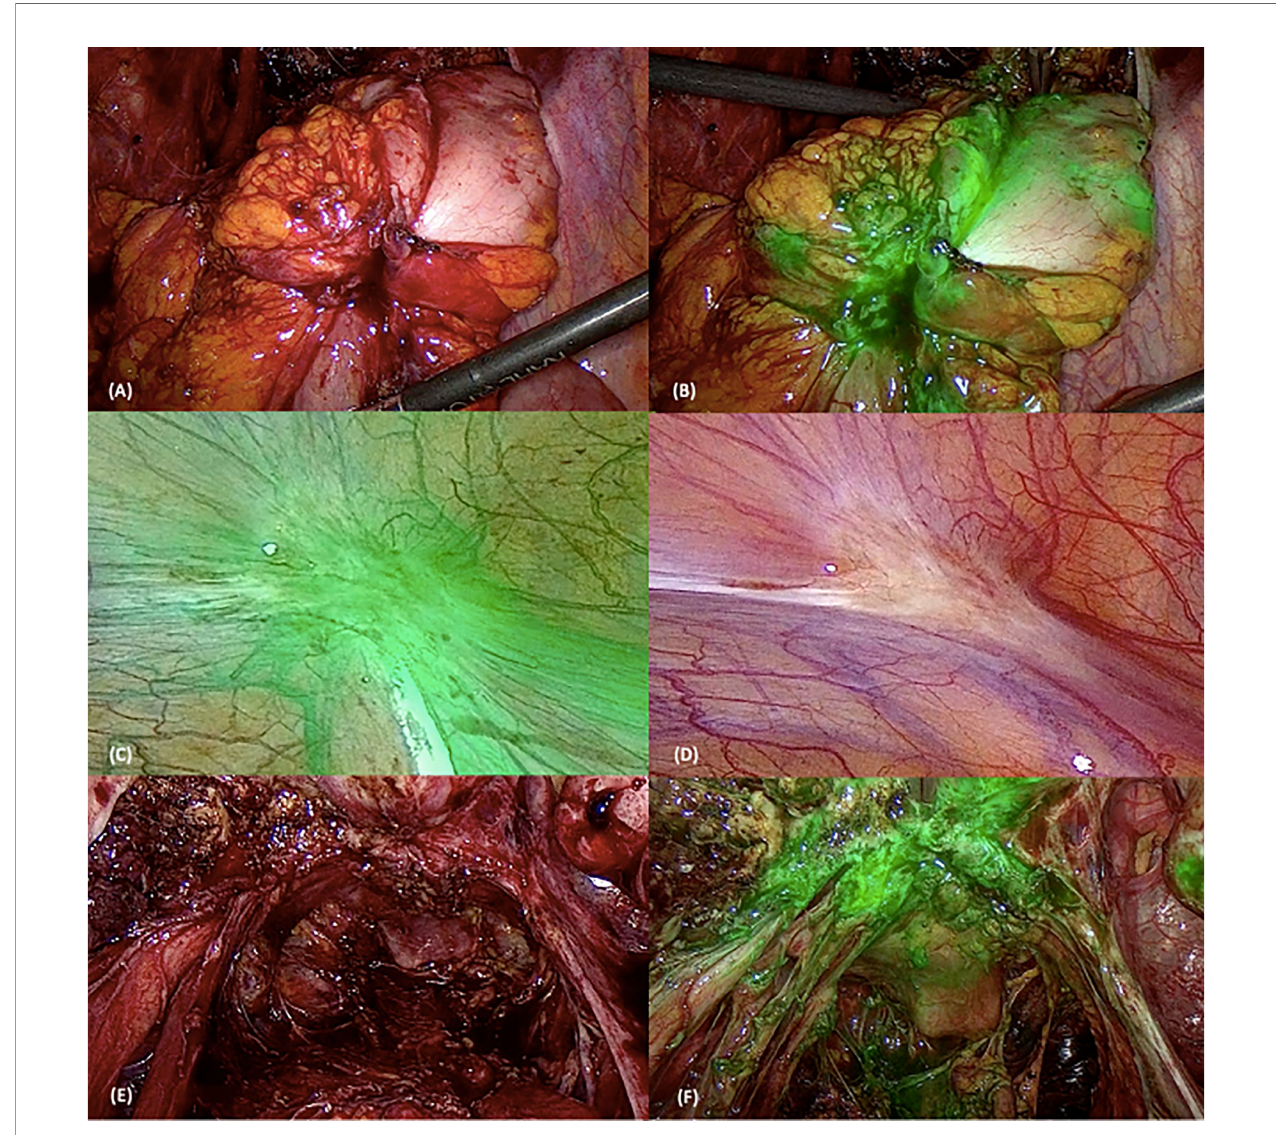
FIGURE 1 | Surgical images using white light (WL) and near-infrared indocyanine green (NIR-ICG) mode. The fi rst two pictures represent a rectosigmoid nodule using WL (A) and NIR-ICG mode (B) . (C, D) Super fi cial peritoneal lesion in WL (D) and NIR-ICG (C) . The last two pictures show retrocervical lesions with uterosacral ligament involvement using the two vision systems [WL in (E) and NIR-ICG in (F)